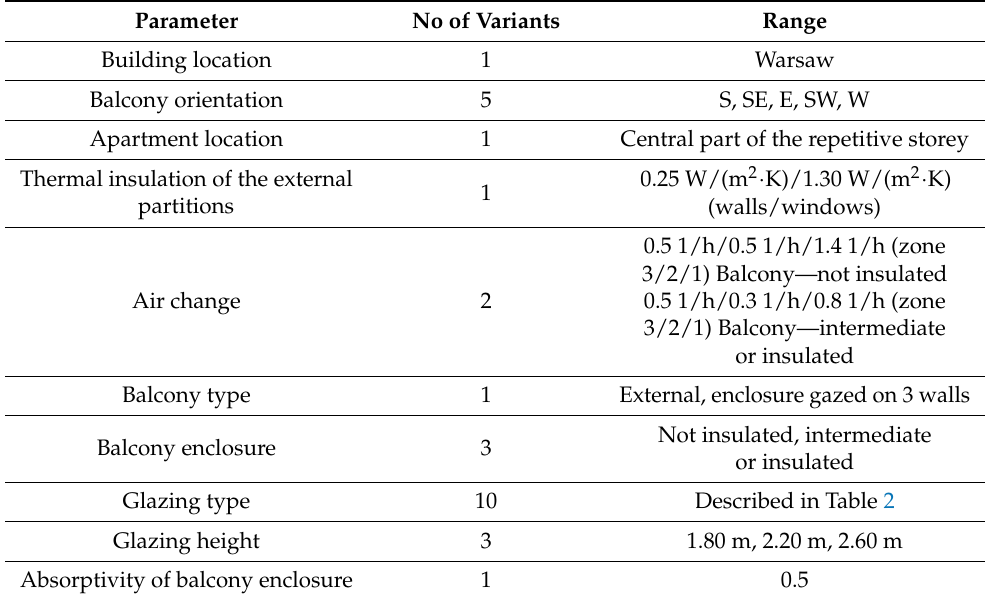
Table 2. The range of the basic parameters assumed in the simulations.